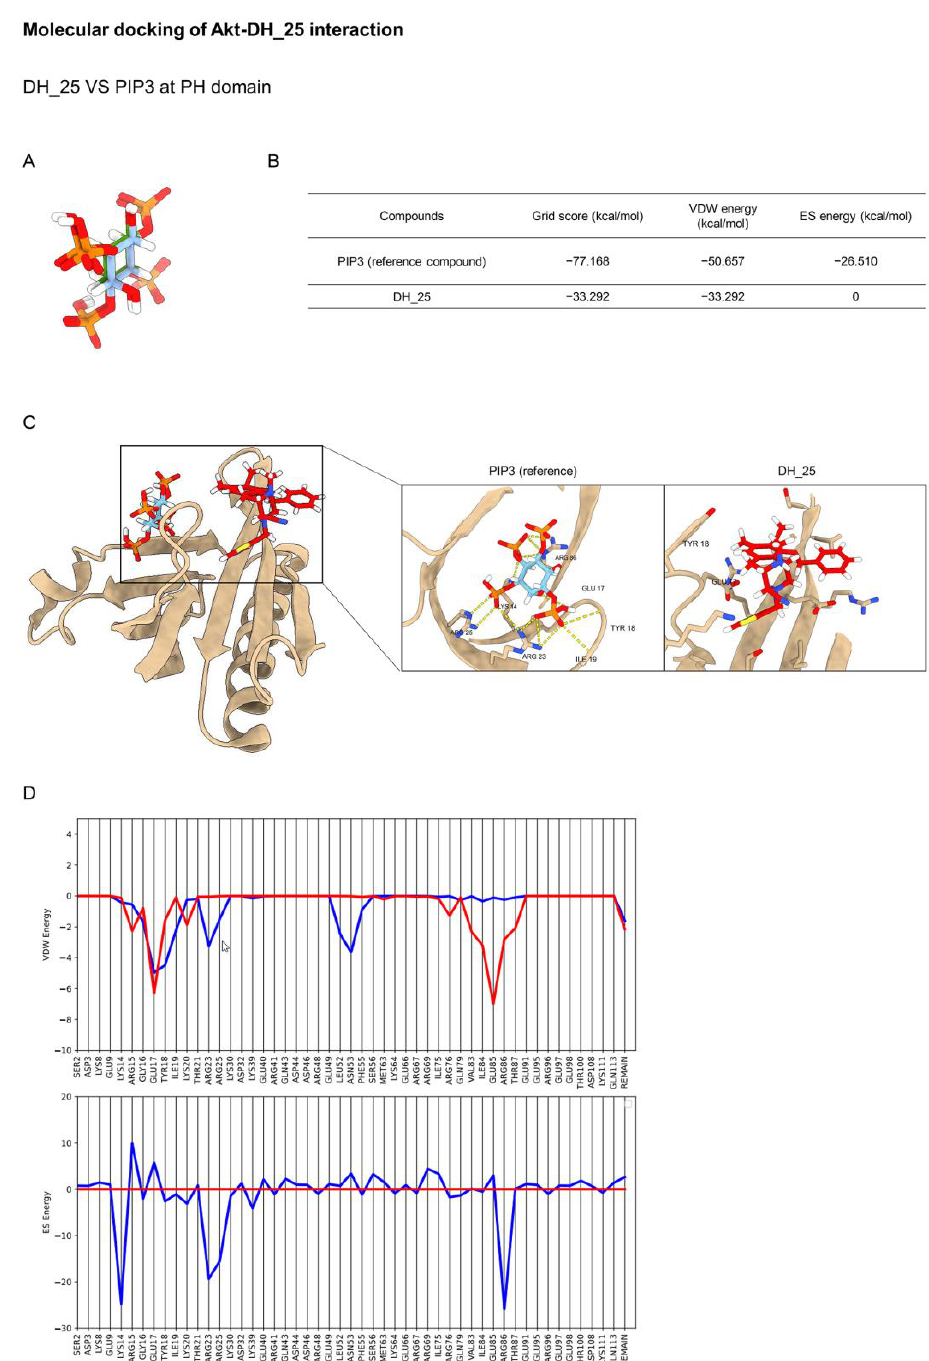
Figure 7. Molecular docking of DH_25 and Akt at the PH domain compared with PIP3. ( A ) Struc- tural superimposition of redocked (blue) and experimental native ligand (green) at the PH domain. ( B ) Binding energies of the ligand in complex with the PH domain of Akt. ( C ) The PH domain of Akt in complex with DH_25 or PIP3 for reference. The yellow dashed lines denote hydrogen-bonding interactions. ( D ) Footprint analysis for DH_25 (red lines) compared with the PIP3 reference (blue lines) into the PH domain of Akt.